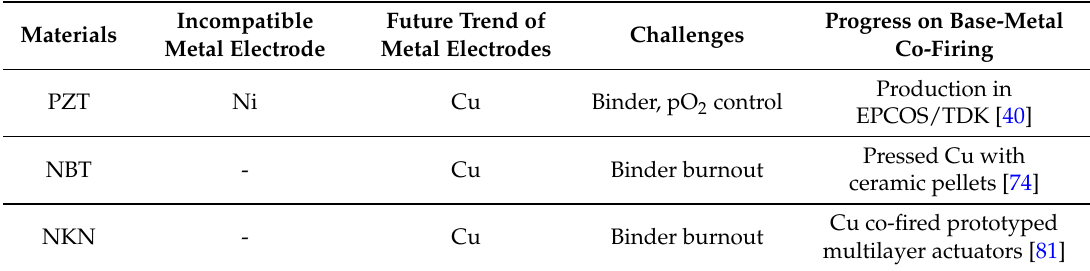
Table 5. Summary of important findings and progress on base metal co-firing for major piezoelectrics.